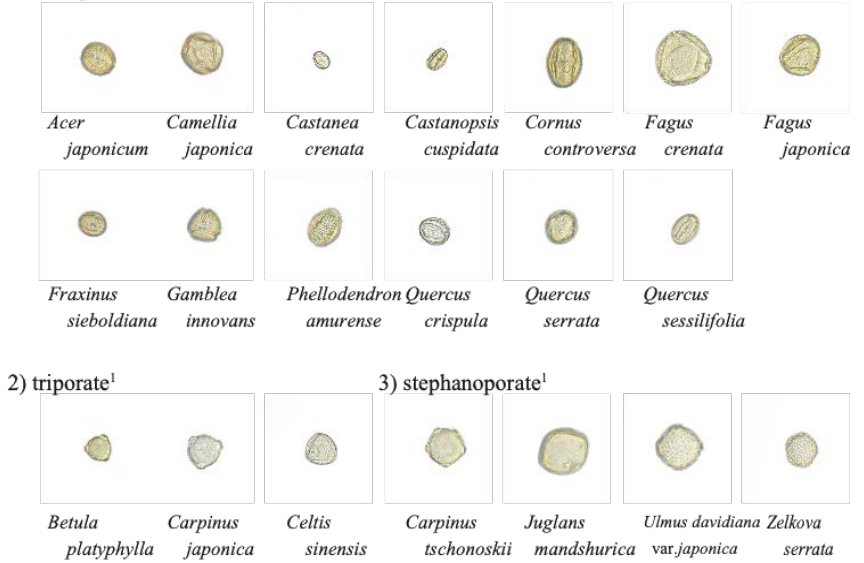
Figure 1. Example pollen grain images used for analysis. The backgrounds of the images have been transparency-treated for easier viewing. 1 Pollen types (Morita ([26])).